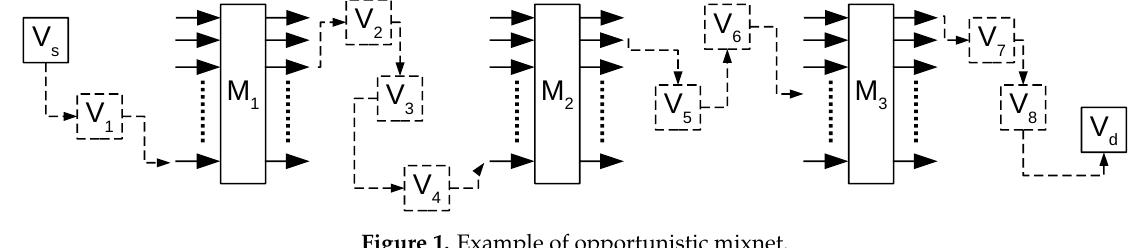
Figure 1. Example of opportunistic